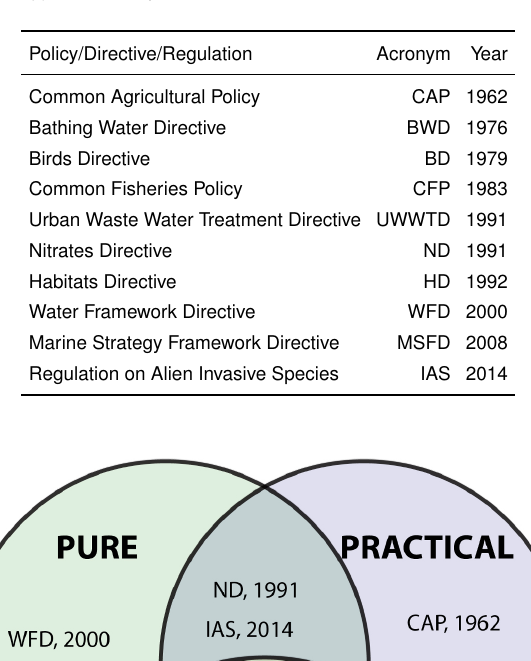
Table 1. Major Directives relating to the EU biodiversity Strategy in the Aquatic environment.